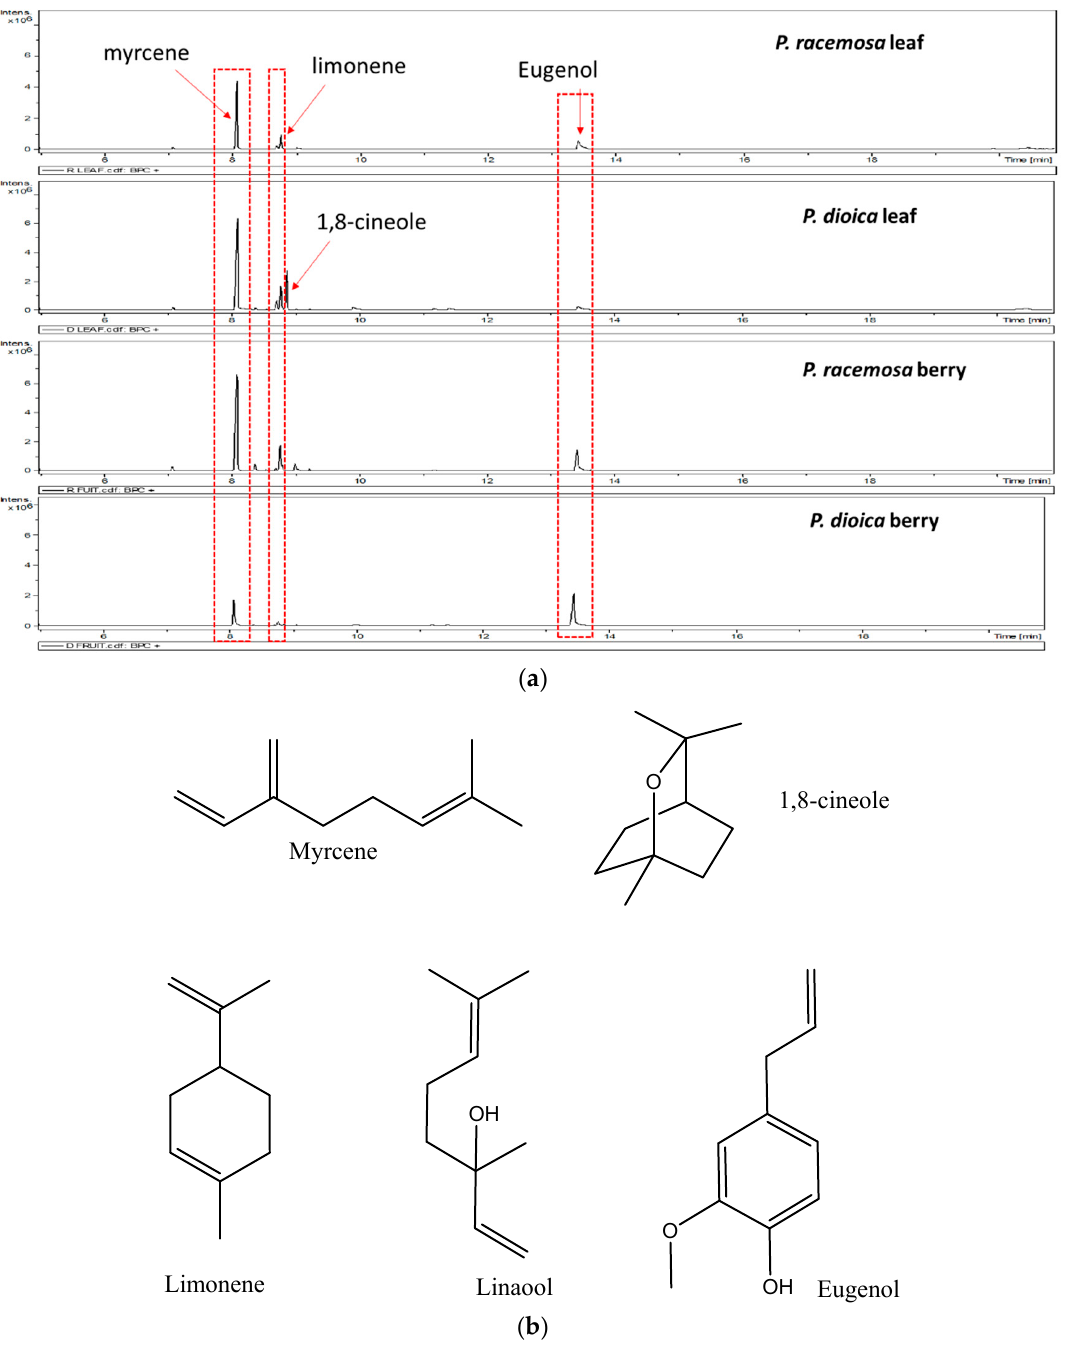
Figure 2. ( a ) Representative GC/MS chromatograms of P. racemosa and P. dioica leaf and berry essential oils. ( b ) Structures of the major volatile constituents detected in P. racemosa and P. dioica essential oils.